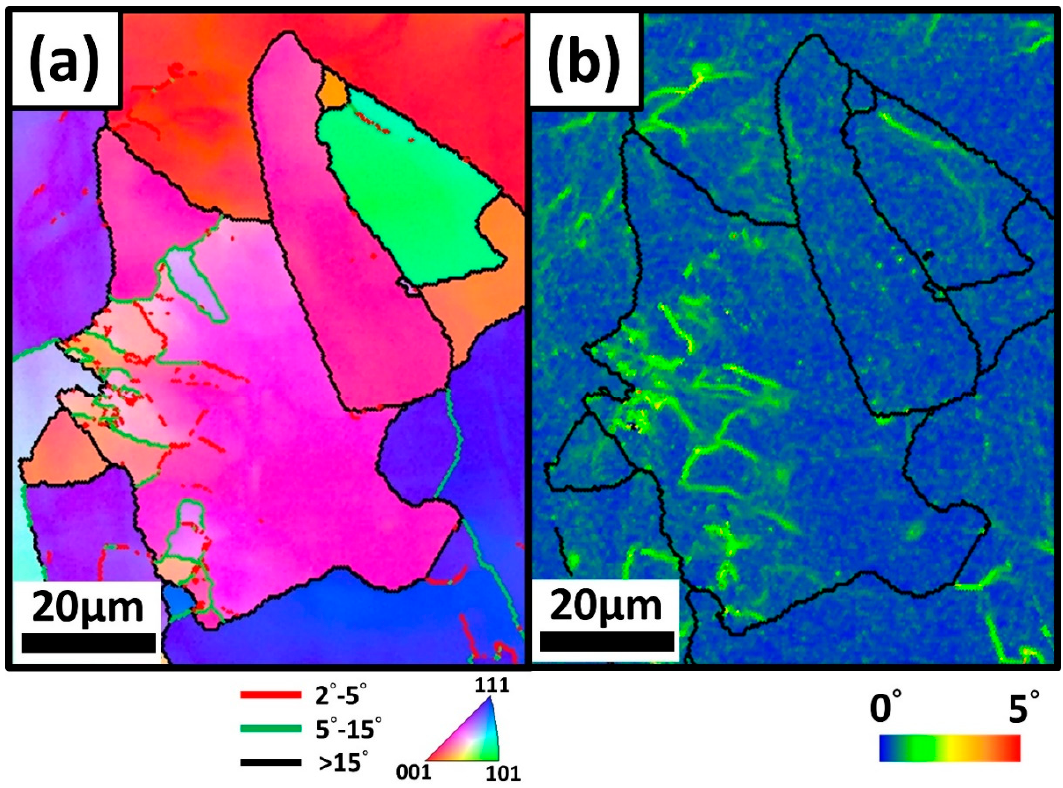
Figure 5. ( a ) inverse pole figure and ( b ) kernel average misorientation analysis of massive ferrite in Steel B.